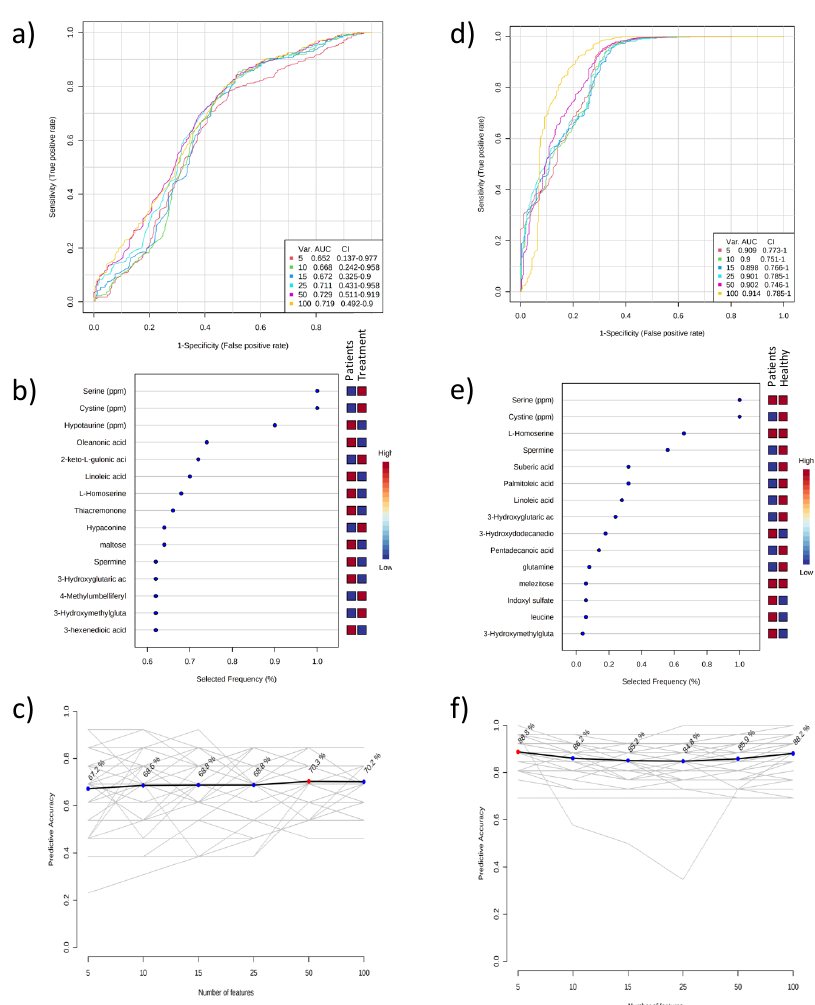
Figure 3. Multivariate ROC curve-based exploration graphs for urine metabolomics analysis. Patient group and treatment group ( a – c ); patient group and healthy control group ( d – f ) ( a , d ); selectivity and sensitivity graphs ( b , e ); the 15 most significant metabolites on the estimation of the method ( c , f ); effects of different numbers of metabolites on the estimation of the